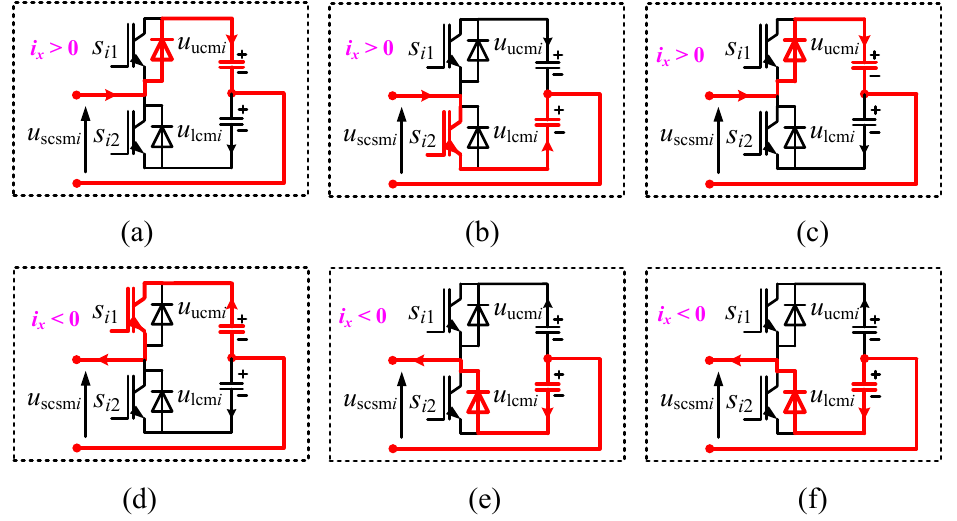
Figure 5. Basic operation mode of SCSM in the hybrid MMC: ( a ) i x > 0, S i 1 = 1, S i 2 = 0; ( b ) i x > 0, S i 1 = 0, S i 2 = 1; ( c ) i x > 0, S i 1 = S i 2 = 0; ( d ) i x < 0, S i 1 = 1, S i 2 = 0; ( e ) i x < 0, S i 1 = 0, S i 2 = 1; ( f ) i x < 0, S i 1 = S i 2 = 0.